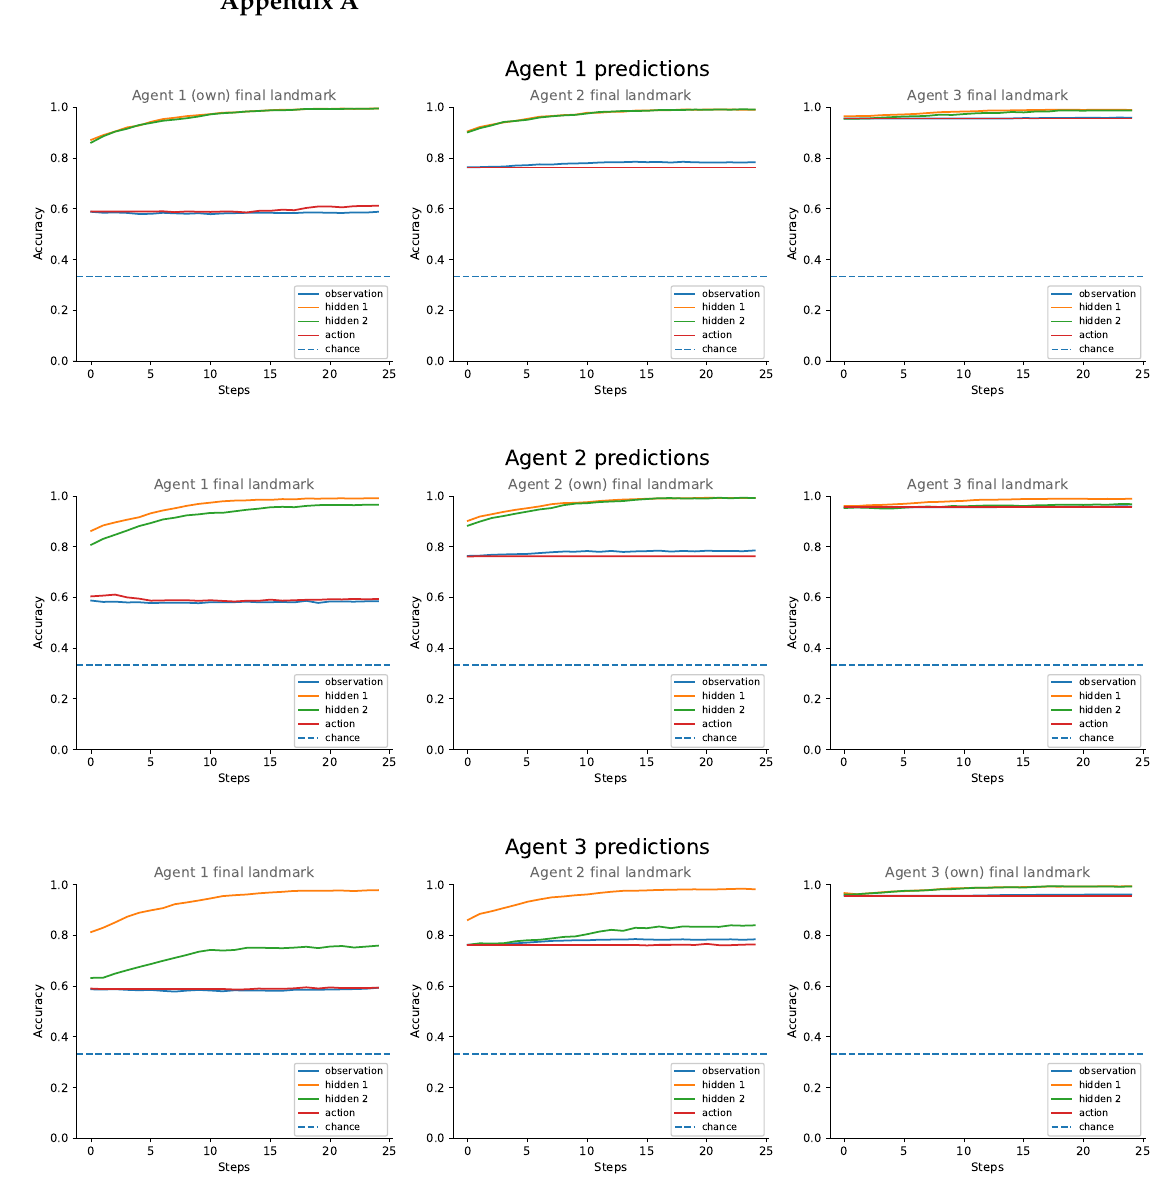
Figure A1. Cross-validated accuracy of linear read-out probe for the vanilla MADDPG algorithm. The predictions are unusually good because of biases of learned agents—the read-out model can score well by just producing constant prediction. For example, agent 3 can be predicted perfectly because in 99% of the cases, it goes to landmark 3 (see Table 1). Still, the comments from Section 5.1